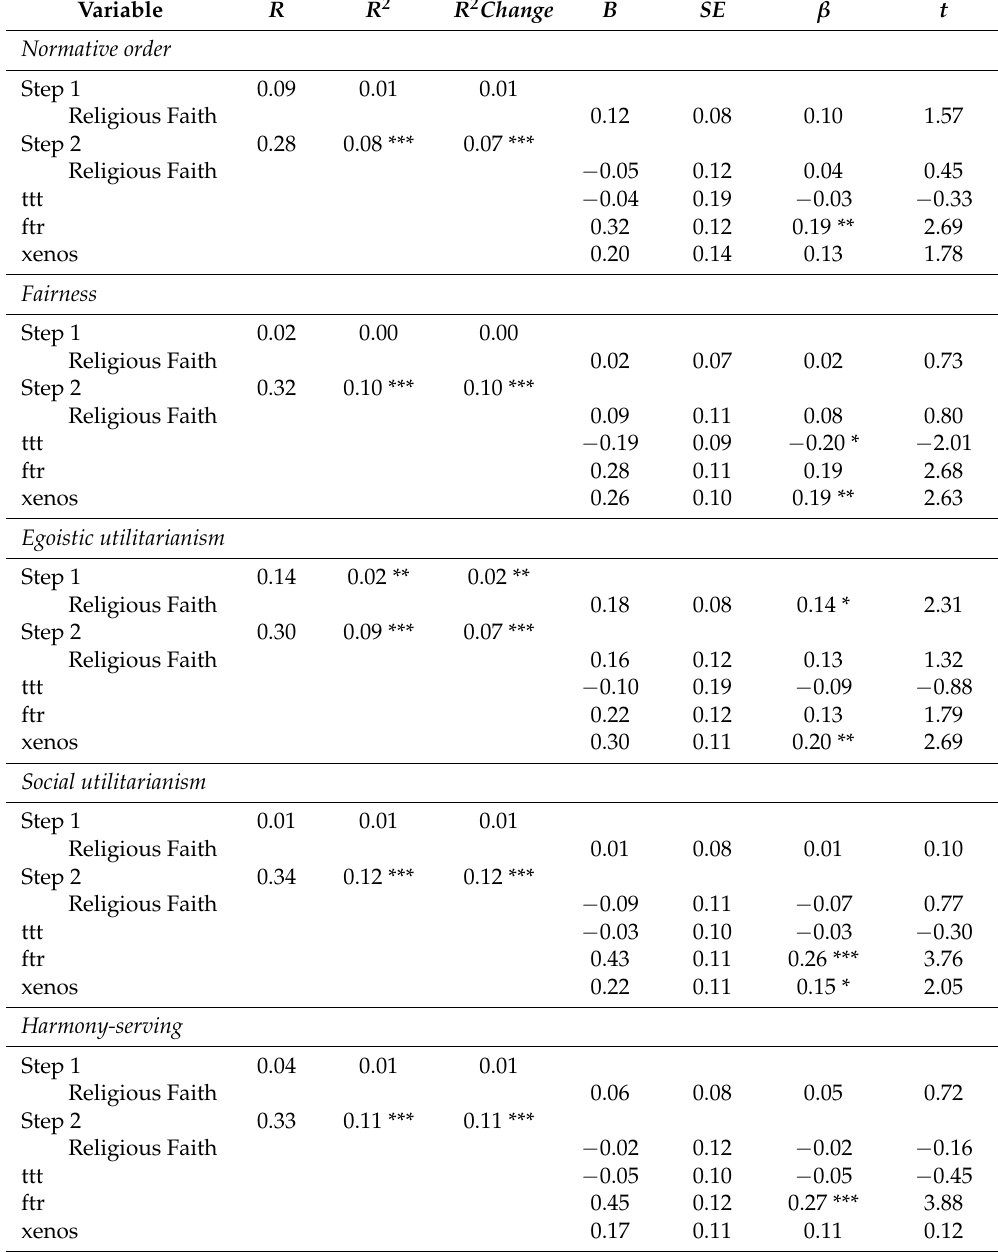
Table 3. Hierarchical Multiple